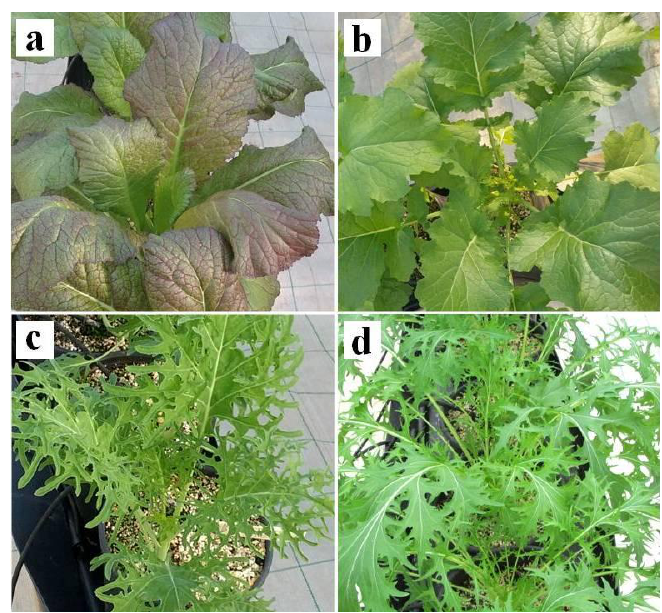
Figure 2. Plants of the four genotypes at the first harvest after 21 days of iodine biofortification. ( a ) red mustard; ( b ) broccoli raab; ( c ) curly kale; and ( d ) mizuna. Table 2. Dry matter (DM), I concentration, and transfer factor (TF) of Brassica genotypes supplied with different levels of I in the nutrient solution (NS), measured after 21 and 43 days after iodine biofortification (I and II